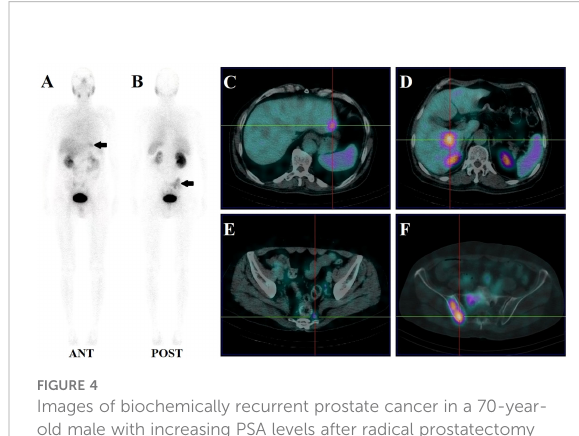
FIGURE 4 Images of biochemically recurrent prostate cancer in a 70-year- old male with increasing PSA levels after radical prostatectomy (PSA, 187.40 ng/ml; Gleason score, 4 + 5). Whole-body planar scintigraphy ( A, B ; pointed by black arrows) and fused SPECT/CT images show multiple metastases in the liver ( C, D ; the highest SUVmax, 4.61), pelvic lymph node ( E ; SUVmax, 1.84), and sacrum and right iliac bone ( F ; SUVmax, 6.82). The patient received chemotherapy and his PSA level decreased to 23.73 ng/ml.